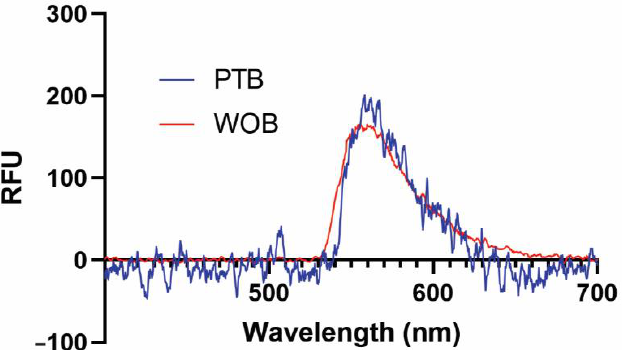
Figure 2. Representative fluorescence spectra of 1 nM streptavidin-Alexa Fluor 532 conjugate from 400–700 nm recorded on WOB (red) and PTB (blue). RFU: relative fluorescence units.